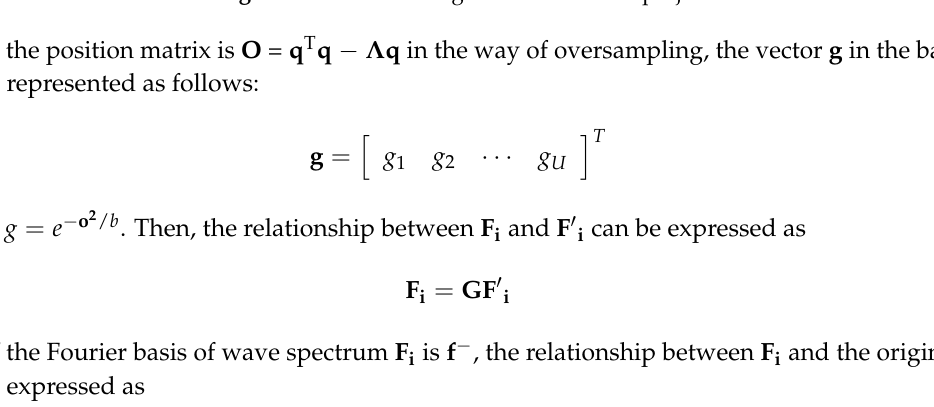
Figure 3. Schematic diagram of wavefront